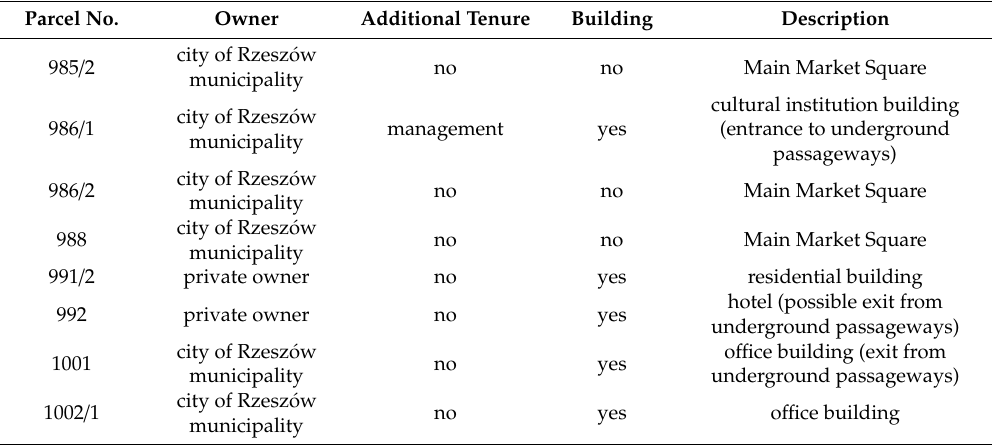
Table 3. Characteristics of the land parcels under which the Underground Tourist Route is located. Parcel